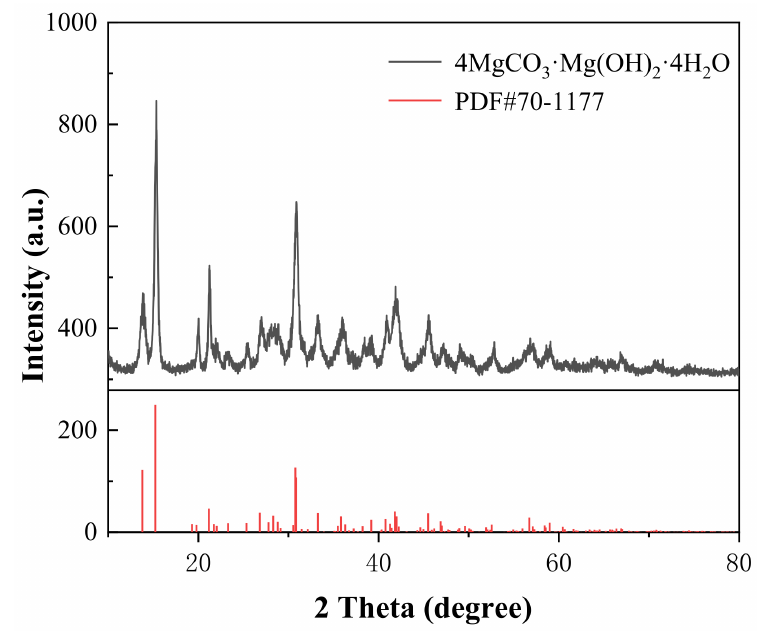
Figure 6. XRD pattern of 4MgCO 3 · Mg(OH) 2 · 4H 2 O.